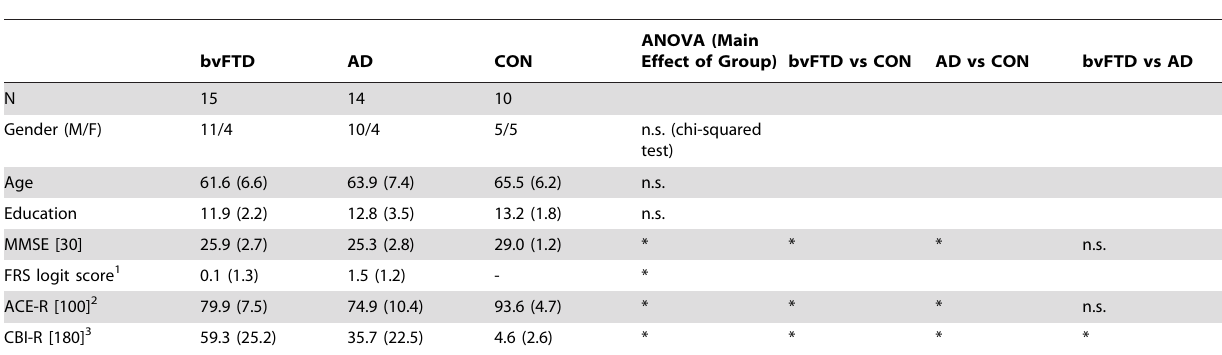
Table 1. Demographics, Cognitive & Behavioural